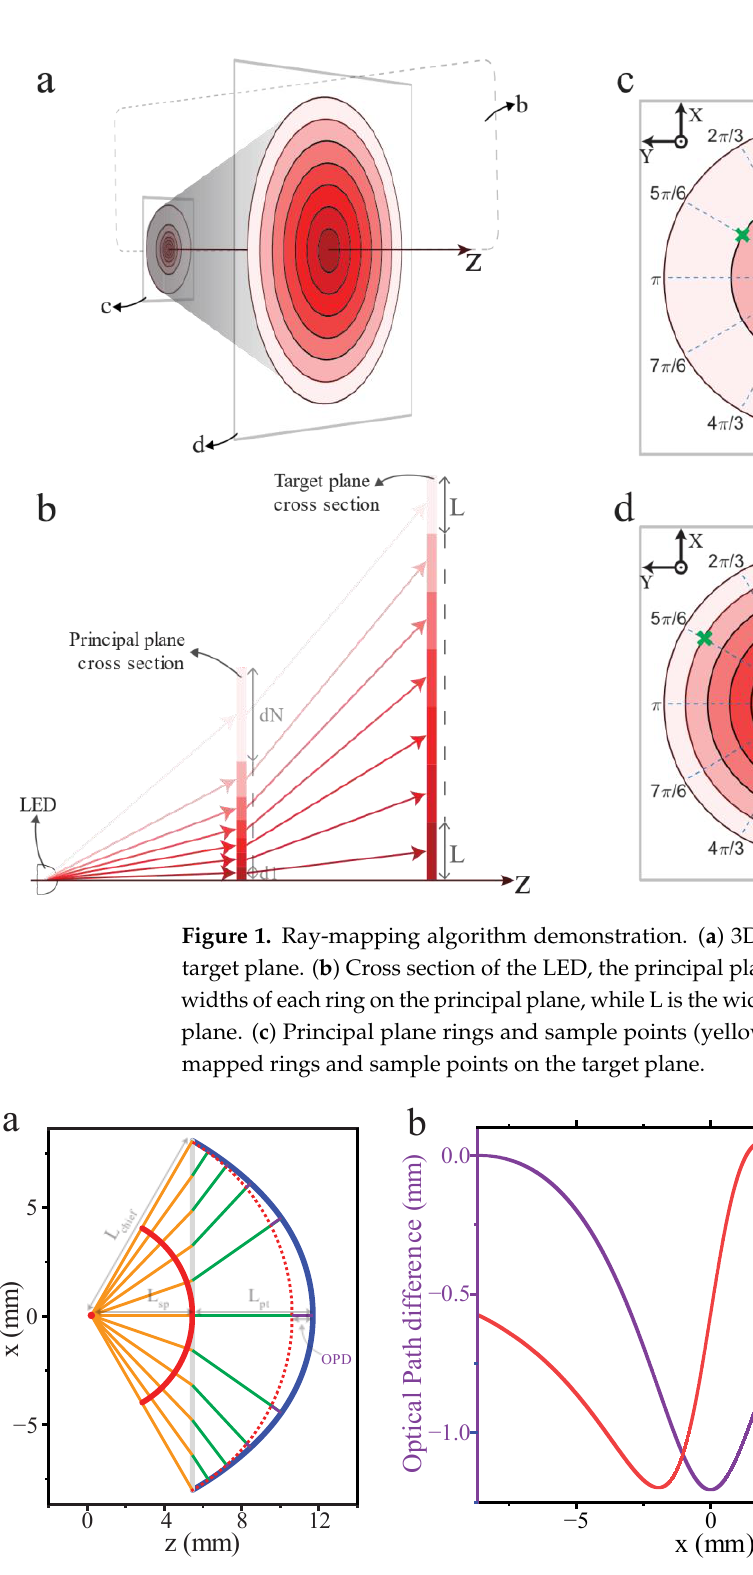
Figure 2. Wavefront tailoring process. ( a ) cross section of the incident (solid red curve), refracted (blue curve) and free-space propagated (dashed red curve) wavefronts to calculate optical path differences. Lens to principal plane and principal plane target plane rays have been illustrated with orange and green line, respectively. ( b ) Required OPD based on wavefront tailoring (purple curve) for each point of the principal plane cross section (gray line on ( a )) and the corresponding lateral momentum change on the lens cross section (red graph).